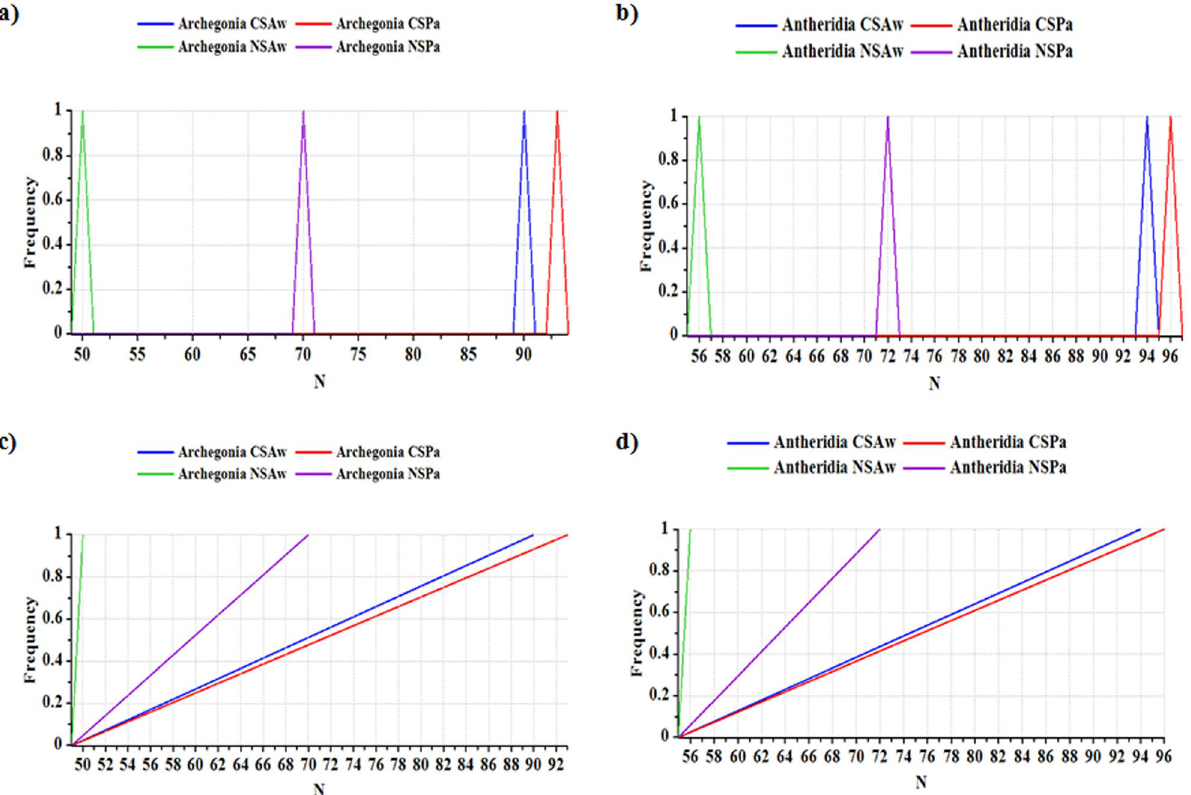
Figure 2. Nickel excess impacts distribution and population viability analysis of liverworts. (a,b) Nickel (Ni) in Ni-excess sites (NS, n = 5) affected the frequency distribution and number (N) of reproductively active archegonia and antheridia of Asterella wallichiana (a) and Plagiochasma appendiculatum (b) compared with the control sites (CS, n = 5). X-axis represents number (N) of mature archegonia and antheridia, while Y-axis represents frequency distribution pattern. (c,d) Quasi-extinction (QE) probability versus threshold curves showed the frequency of occurrence (FOC) of reproductively active antheridia and archegonia as an indicator of population viability of A . wallichiana and P . appendiculatum . Green and violet lines show the impact of Ni excess on the FOC of archegonia (c) and antheridia (d) , respectively in NS compared to blue and red colored lines showing FOC of archegonia (c) and antheridia (d) in CS. X-axis represents the number (N) of reproductively active antheridia and archegonia, while Y-axis represents the frequency distribution pattern of the A . wallichiana and P . appendiculatum in CS and NS sites. ‘Archegonia CS + Aw ’ and ‘Archegonia CS + Pa ’ denote ‘control sites + A . wallichiana ’ and ‘control sites + P . appendiculatum, respectively. ‘Archegonia NS + Aw ’ and ‘Archegonia NS + Pa ’ denote ‘Nickel excess sites + A . wallichiana ’ and ‘Nickel excess sites + P . appendiculatum, respectively. ‘Antheridia CS + Aw ’ and ‘Antheridia CS + Pa ’ denote ‘control sites + A . wallichiana ’ and ‘control sites + P . appendiculatum ’, respectively. ‘Antheridia NS + Aw ’ and ‘Antheridia NS + Pa ’ denote ‘Nickel excess sites + A . wallichiana ’ and ‘Nickel excess sites + P . appendiculatum ’,